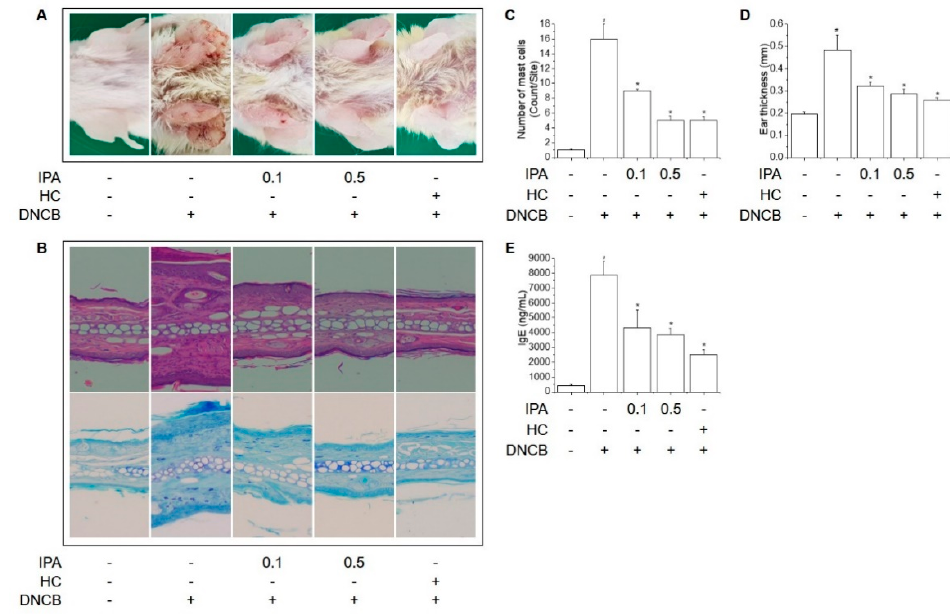
Figure 2. Inhibitory effect of IPA on DNCB-induced AD-like skin lesions in BALB/C mice. After inducing AD using DNCB, vehicle, IPA (0.1 and 0.5%, w/v) and HC (1%, w/v) was topically applied to the dorsal skin and ears of the mice six times per week for 4 weeks. ( A ) Representative image of AD-like ear lesions on the last day. ( B ) Histopathological analysis by H&E and toluidine blue staining of AD-like ear lesions. ( C ) Numbers of mast cells. ( D ) Ear thickness measured using a micrometer. ( E ) Serum IgE concentrations were assessed by ELISA. Results are means ± SD (n = 6). # p < 0.05, versus the control group; * p < 0.05, versus the DNCB-treated group. IPA: Impressic acid; HC: Hydrocortisone; DNCB: 2,4-dinitrochlorobenzene.